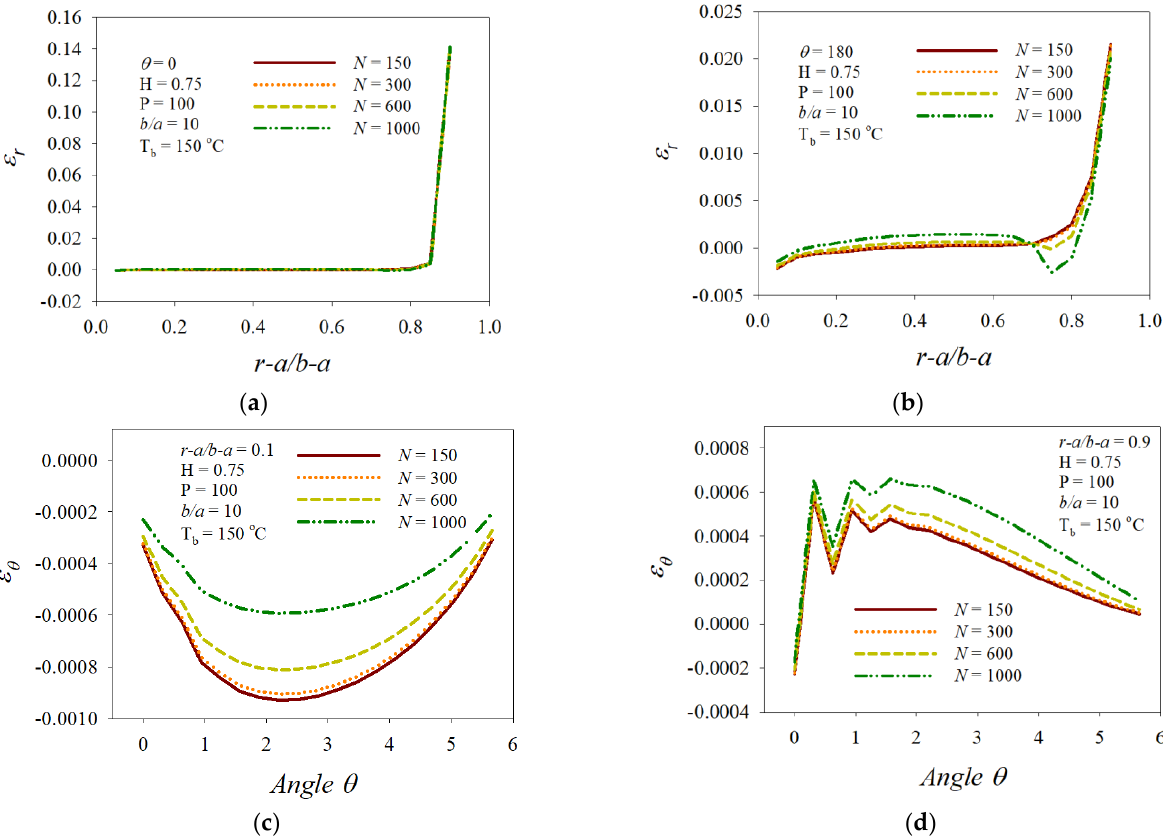
Figure 9. Effects of angular velocity on the components of strain: ( a ) Radial at θ = 0, ( b ) radial at θ = 180 , ( c ) circumferential at (r − a)/(b − a) = 0.1, ( d ) circumferential at (r − a)/(b − a) = 0.9.